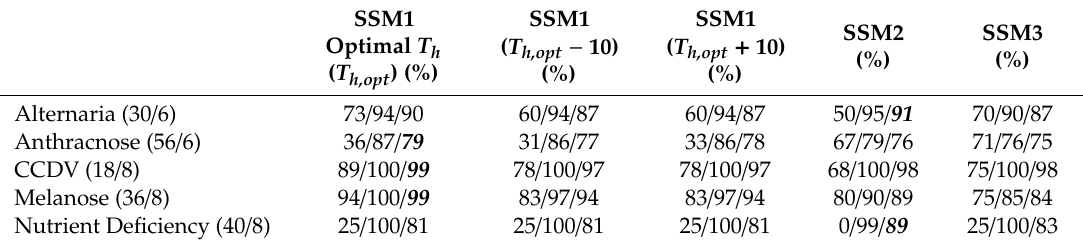
Table 3. Sensitivity / specificity / accuracy of group B. The parentheses next to the name of the diseases denote (test / training samples). The SSM with the best accuracy for each disease is highlighted with bold-italics.